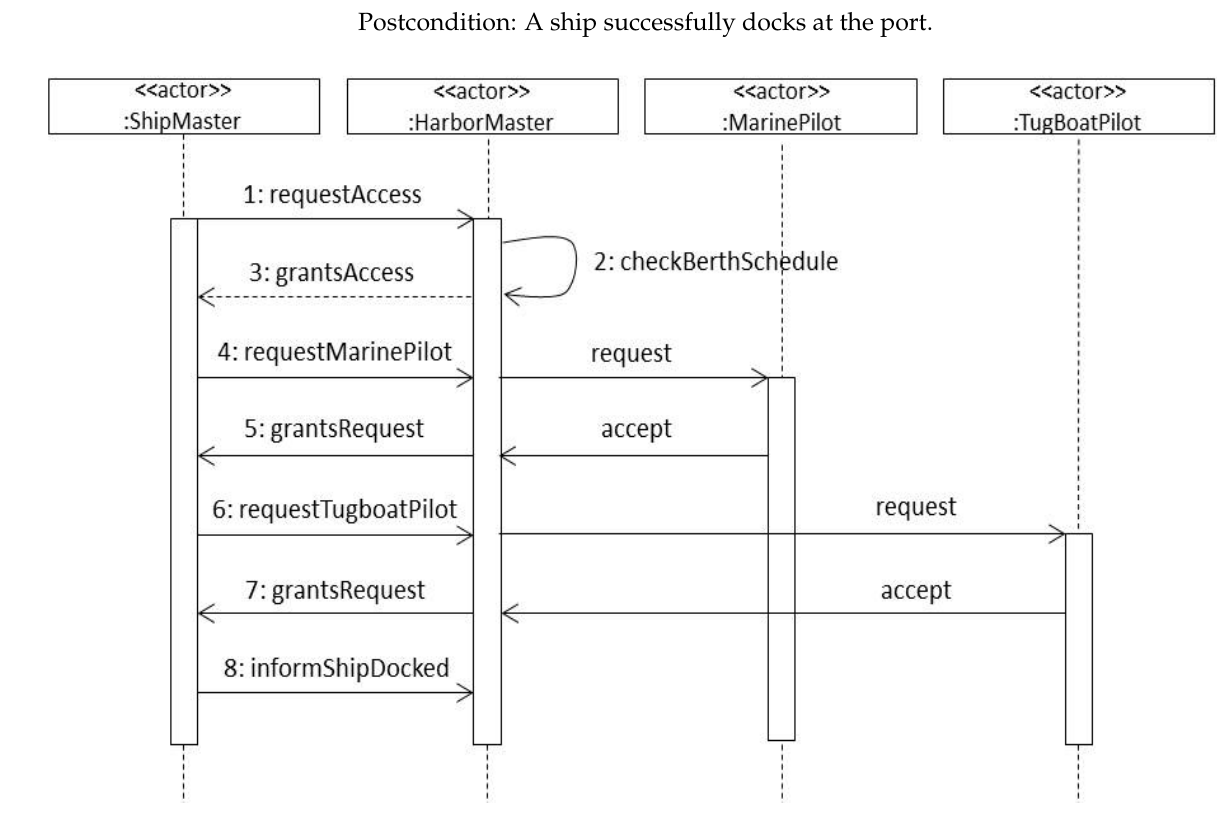
Figure 12. Sequence diagram for UC ship arrival.